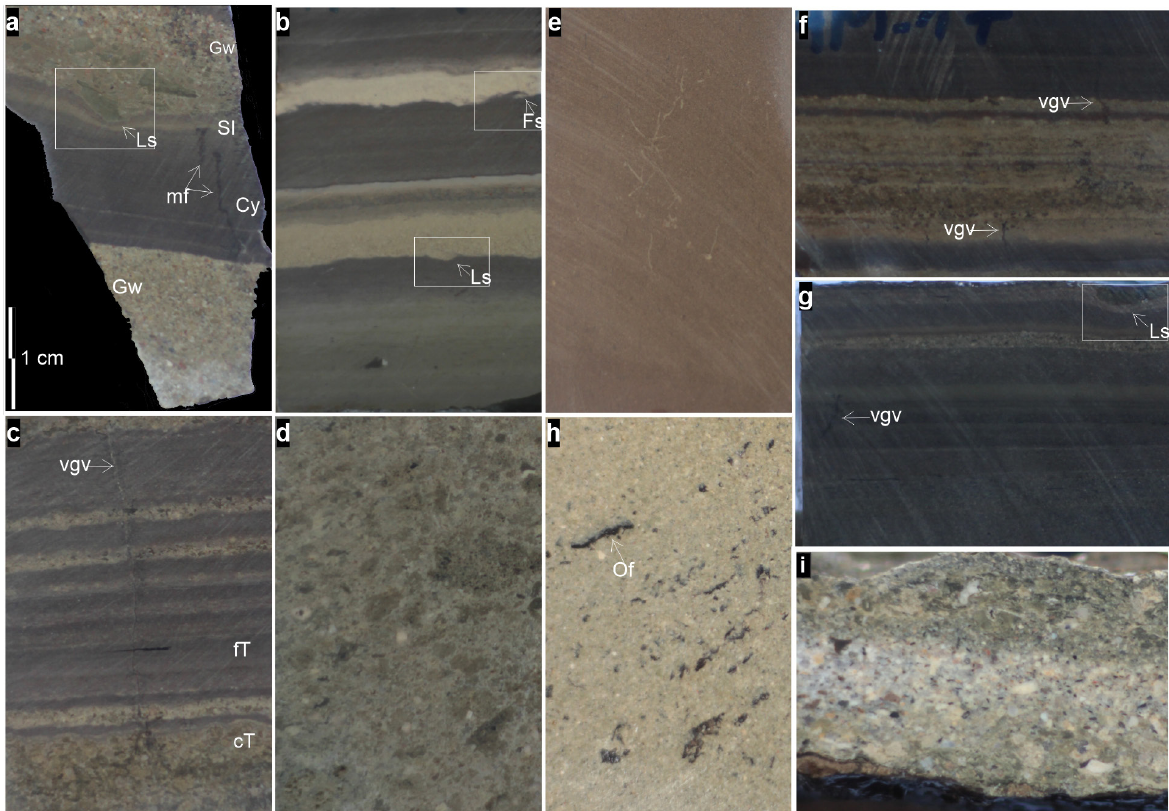
Figure 4. Samples macrophotographs showing the different lithofacies. a) Sample M.5, medium to coarse-grained graywacke (Gw) with interbedded planar laminated claystone (Cy) and siltstone (Sl) levels that are crossing by two microfractures (mf) and to the top an overload structure (Ls) is observed lying on the finer sediments. b) Sample M.7, claystone, siltstone and very fine-grained sandstone interspersed with flame structure (Fs) and Ls. c) Sample M.14, fine (fT) and coarse-grained (cT) ash tuff laminae crossed by a volcanic glass vein (vgv). d) Sample M.14, matrix-supported lapilli tuff. e) Sample M.15, massive siltstone. f) Sample M.17, siltstone laminae with interbedded fine and coarse-grained ash tuff, several volcanic glass veins are crossing these. g) Sample M.23, fine to medium- grained ash tuff interbedded with few siltstone fine laminae. h) Sample M.25, matrix-supported lapilli tuff with abundant black organic fragments (Of). i) Sample M.27, clast-supported tuffaceous